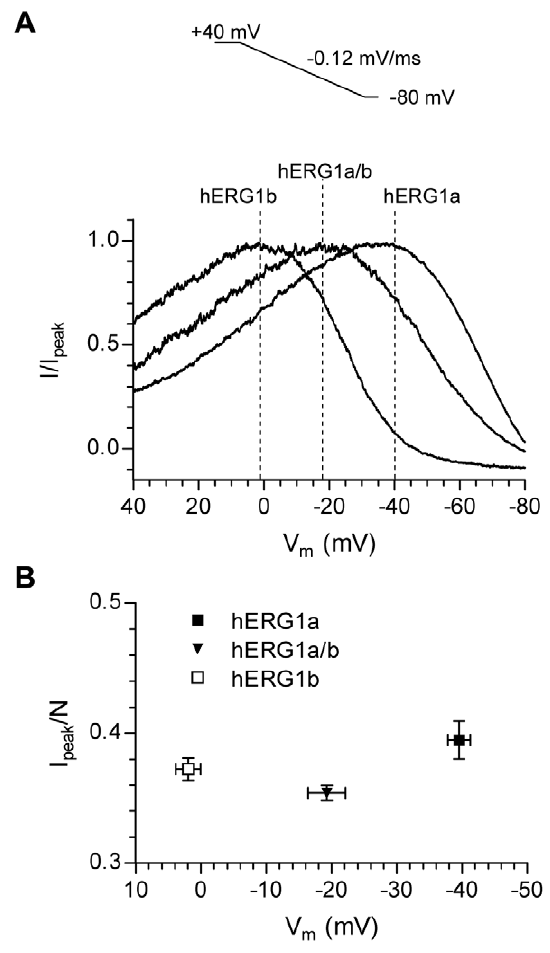
Figure 2. The relative abundance of hERG1a and hERG1b determines the ‘peak potential’ in mammalian cells. A, Representative recordings of hERG1a, hERG1b and hERG1a/b channels expressed in HEK293 cells are shown. Currents were recorded using the protocol depicted in the inset. Only currents recorded during the ramp are shown. For comparison, currents were normalized to the maximum peak current during the ramp and plotted against the command voltage. The dotted lines indicate the potential where the currents peaked (‘peak potential’) and are also used to indicate the expressed channels. B, Summary data of the variation in ‘peak potential’. For comparison, the peak amplitude was normalized to an estimate of the number of channels (N) and plotted as a function of the ‘peak potential’.